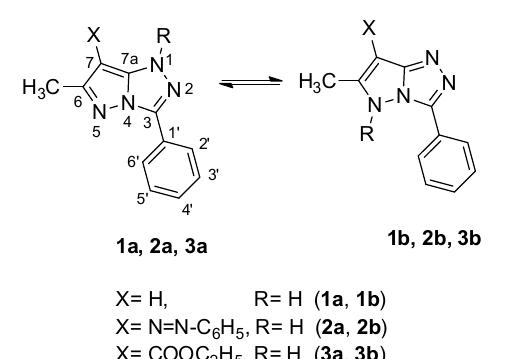
Figure 1. Tautomeric forms in the 3,6-di- and 3,6,7-trisubstituted pyrazolo[5,1-c][1,2,4]triazole